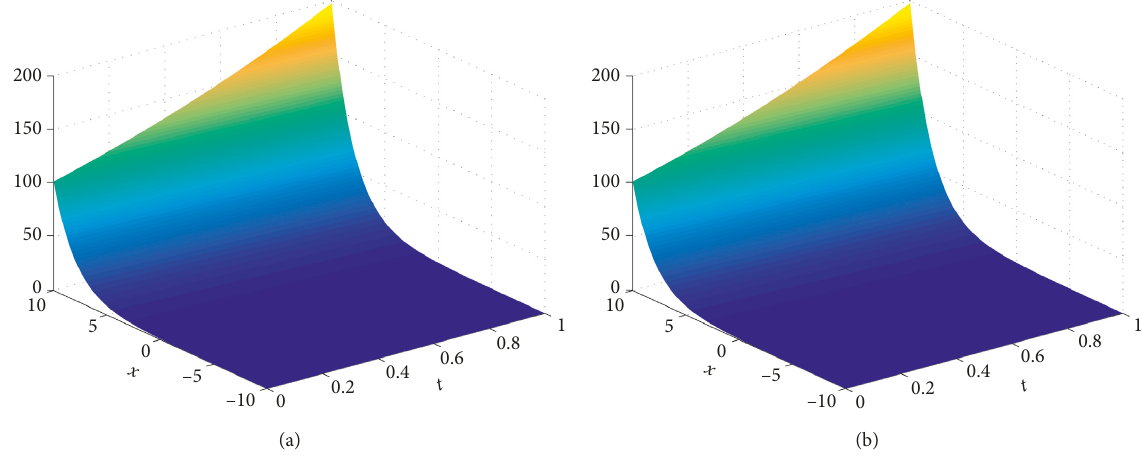
. (b) 􏽥 u ( x,t ) exact LSRPSM